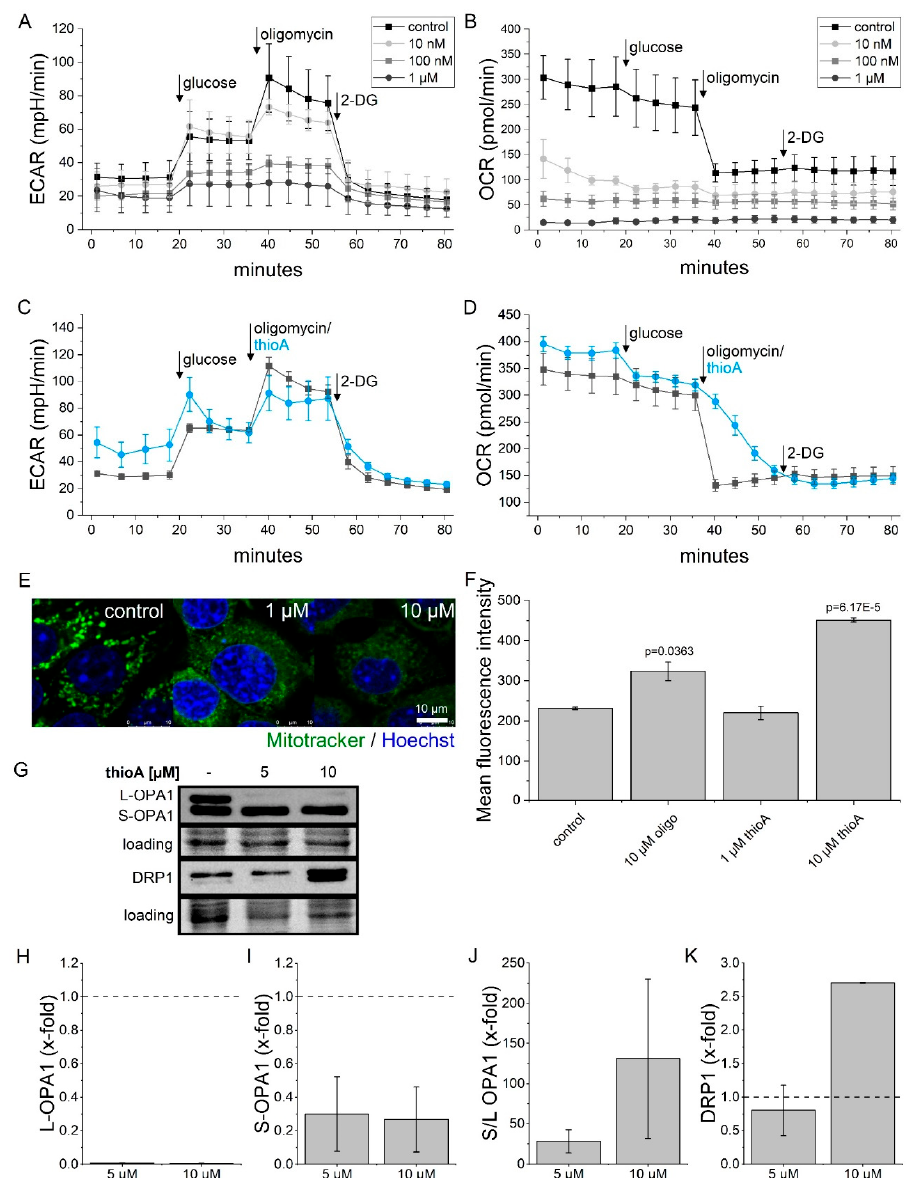
Figure 3. ThioA effects on tumor cell metabolism and mitochondria. Extracellular acidification rate (ECAR) and oxygen consumption rate (OCR) were measured in RIL175 cells in a glycolysis stress test using a Seahorse 96XF instrument. Cells were either pre-treated for 24 h with 10 nM, 100 nM, or 1 µM thioA ( A , B ), or the injection of the ATP synthase inhibitor oligomycin (1 µM) was replaced by an injection of 1 µM thioA ( C , D ). The mitochondrial morphology of RIL175 cells treated for 24 h with thioA was visualized by Mitotracker Green (mitochondria) and Hoechst (nuclei) co-staining, followed by confocal live cell imaging. Microscopy revealed a diffuse staining ( E ). Mitochondrial mass of RIL175 cells was analyzed via flow cytometry after 24 h treatment with vehicle control, thioA or oligomycin (oligo), respectively ( F ). Expression of the mitochondrial fission markers OPA1 and DRP1 were analyzed by immunoblotting in RIL175 cells after 24 h thioA treatment ( G ). ThioA increased the S/L OPA1 ratio ( H – J ) and DRP1 levels ( K ). One representative Western blot is shown including a loading control for total protein. Whole blots are shown in Figure S5. Vehicle control-treated cells were used for data normalization. Statistical analysis was performed using one-way ANOVA and Dunnett post-test. n = 3 (triplicates), n = 2 for DRP1